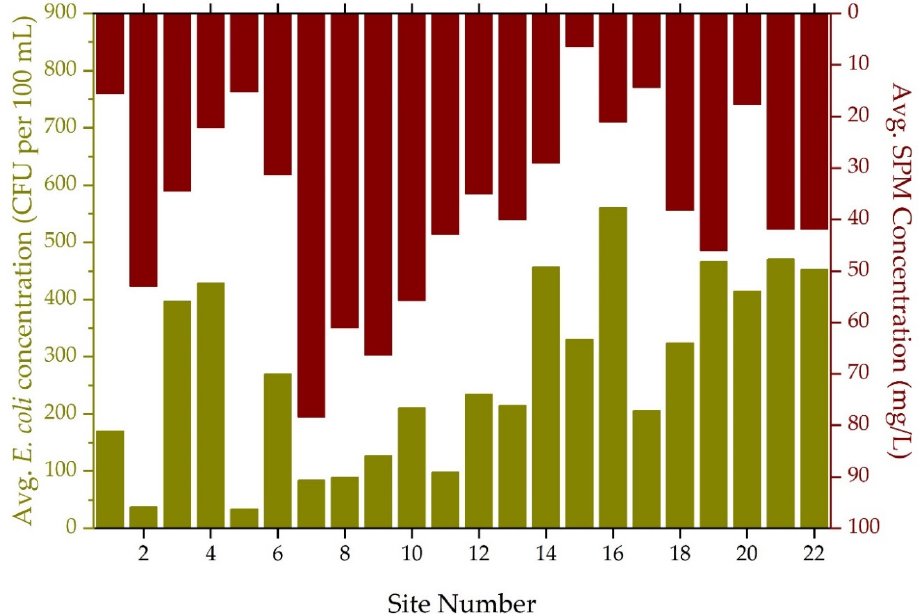
Figure 5. Average suspended particulate matter (mg L − 1 ) and E. coli concentration (CFU per 100 mL) at each sampling location (n = 22) during the study period (2 January 2018–1 January 2019) in West Run Watershed, Morgantown, West Virginia, USA.